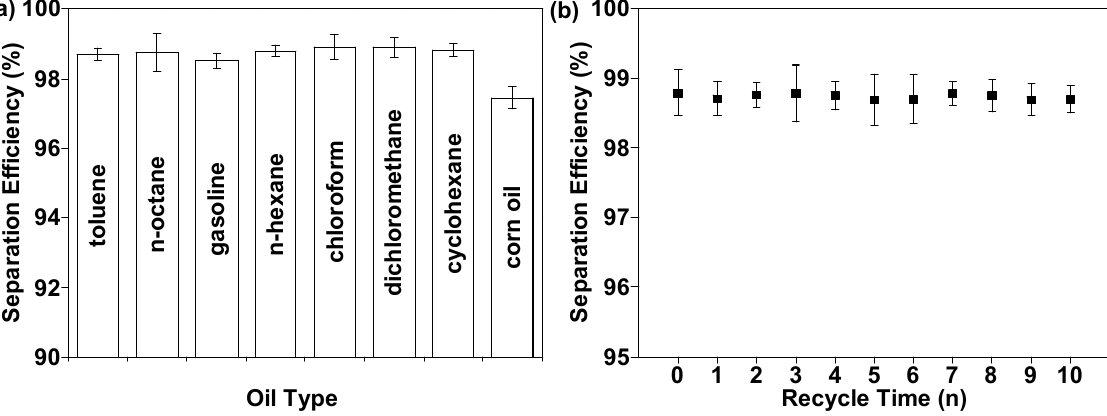
Figure 8. ( a ) Oil/water separation efficiencies of OTS@Fe 2 O 3 -NCs@SSM for oil or organic solvents. ( b ) Separation efficiency for the n-hexane/water mixture after 10 cycles. Table 1. Comparison of various meshes for oil/water separation. Matrix